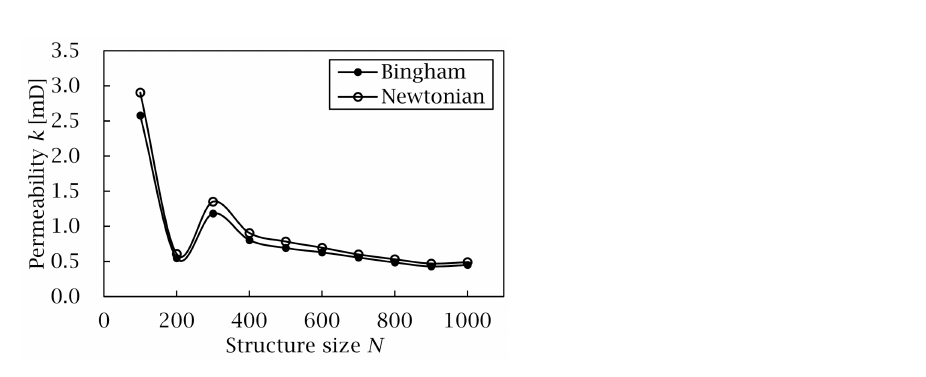
Figure 14. Results of permeability change with structure size for Bingham and Newtonian fluid flow.